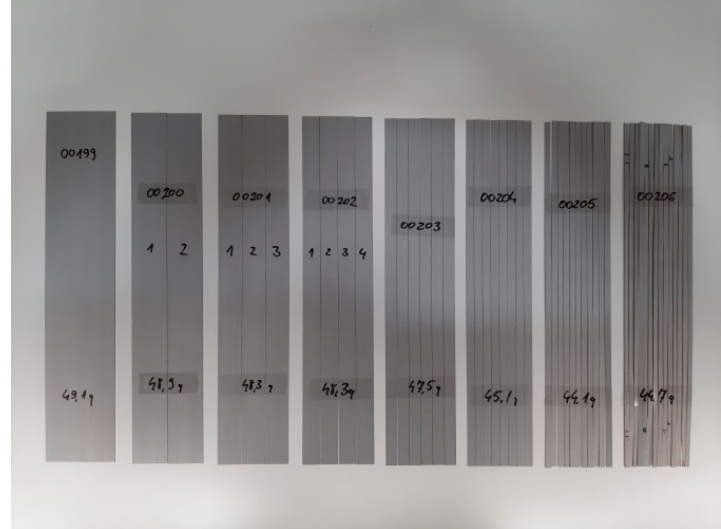
Figure 10. Exemplary samples.